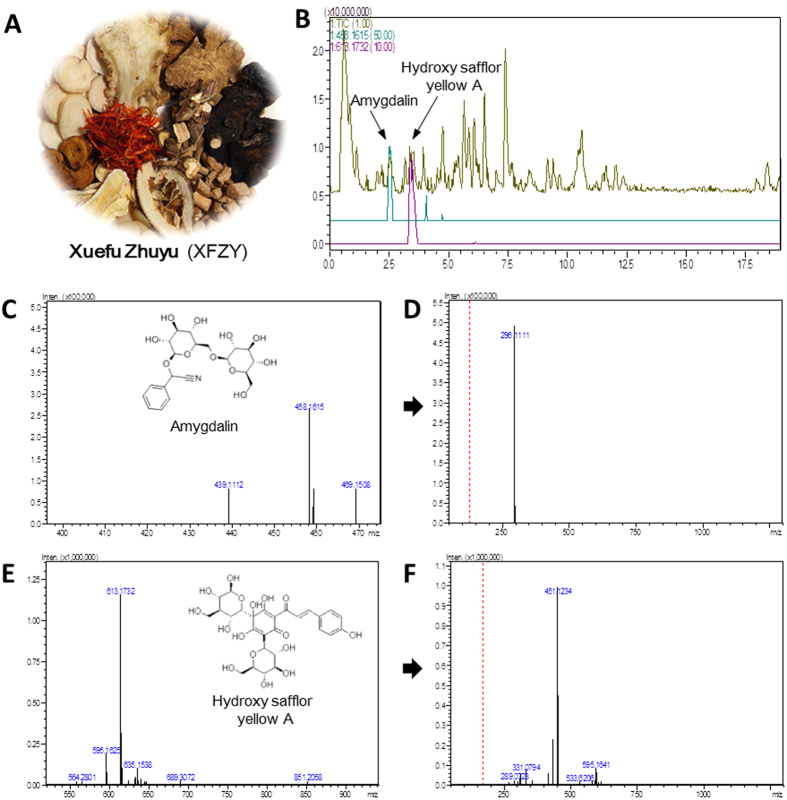
Liquid chromatography coupled to high-resolution ion trap and time-of-flight mass spectrometry (LCMS-IT-TOF) analysis for HSYA and Amygdalin determination, which originated from the monarch drug of XFZY.(A) Prepared Chinese herbal medicines of XFZY in small amounts that are ready for decoction. (B) LCMS-IT-TOF TIC chromatograms of XFZY in positive ESI mode and chromatographic profiles of Amygdalin and HSYA. (C,D) MS1 and MS2 of Amygdalin were m/z 458.16 and 296.11, respectively. (E, F) MS1 and MS2 of HSYA were m/z 613.17 and 451.12, respectively.